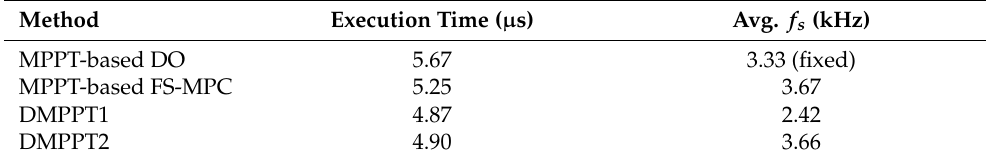
Table 5. Execution time and average switching frequency for the MPPT